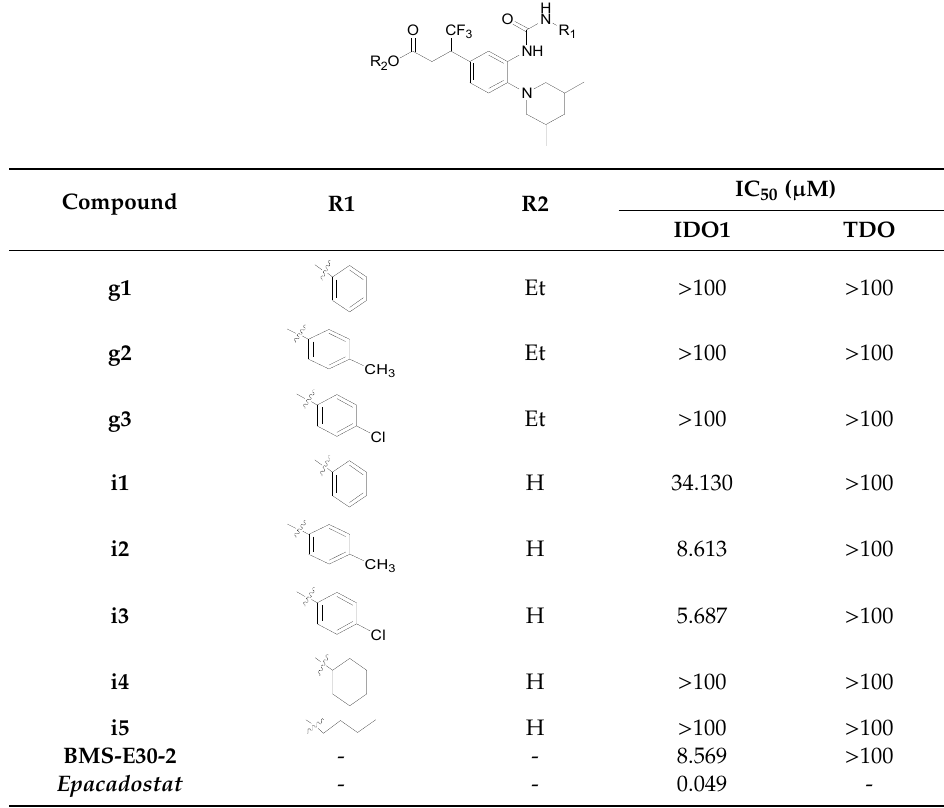
Table 2. IC 50 values of compounds i1–i3 , i6–i24 and j1–j3 against IDO1 and TDO.